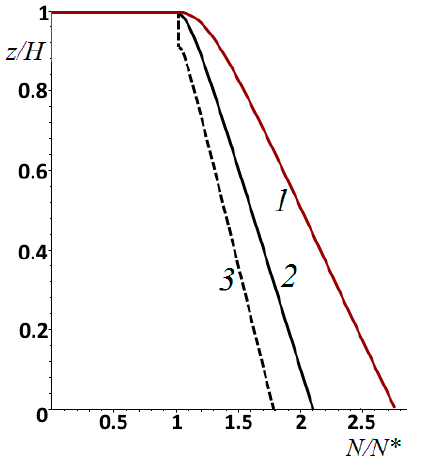
Figure 9. Displacement of the layer surface due to fatigue wear at different loading conditions: am-